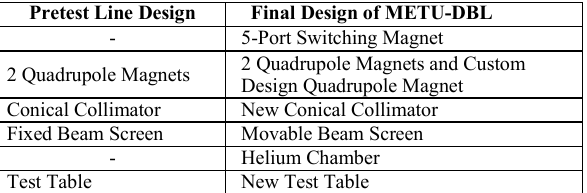
TABLE III. Differences between the pretest and final design of METU- DBL.